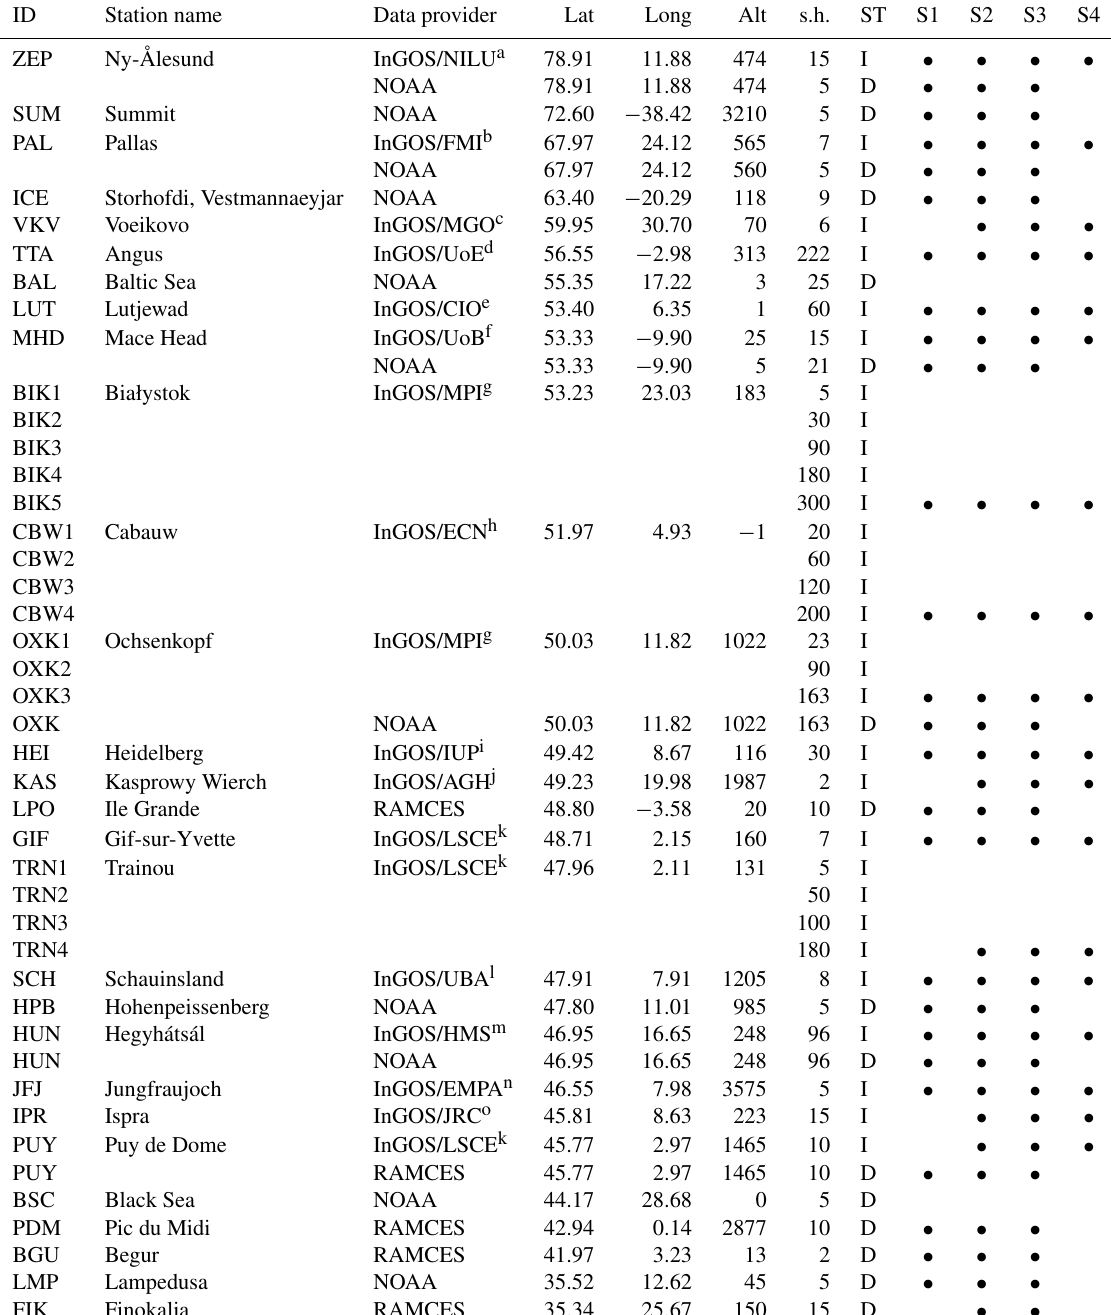
Table 1. European monitoring stations used in this study: s.h. is the sampling height (m) above ground; ST specifies the sampling type (I is in situ measurements; D is discrete air sample measurements). The last four columns indicate the use of the corresponding station data set in the inversions S1–S4 (see Sect. 3.1 and Table